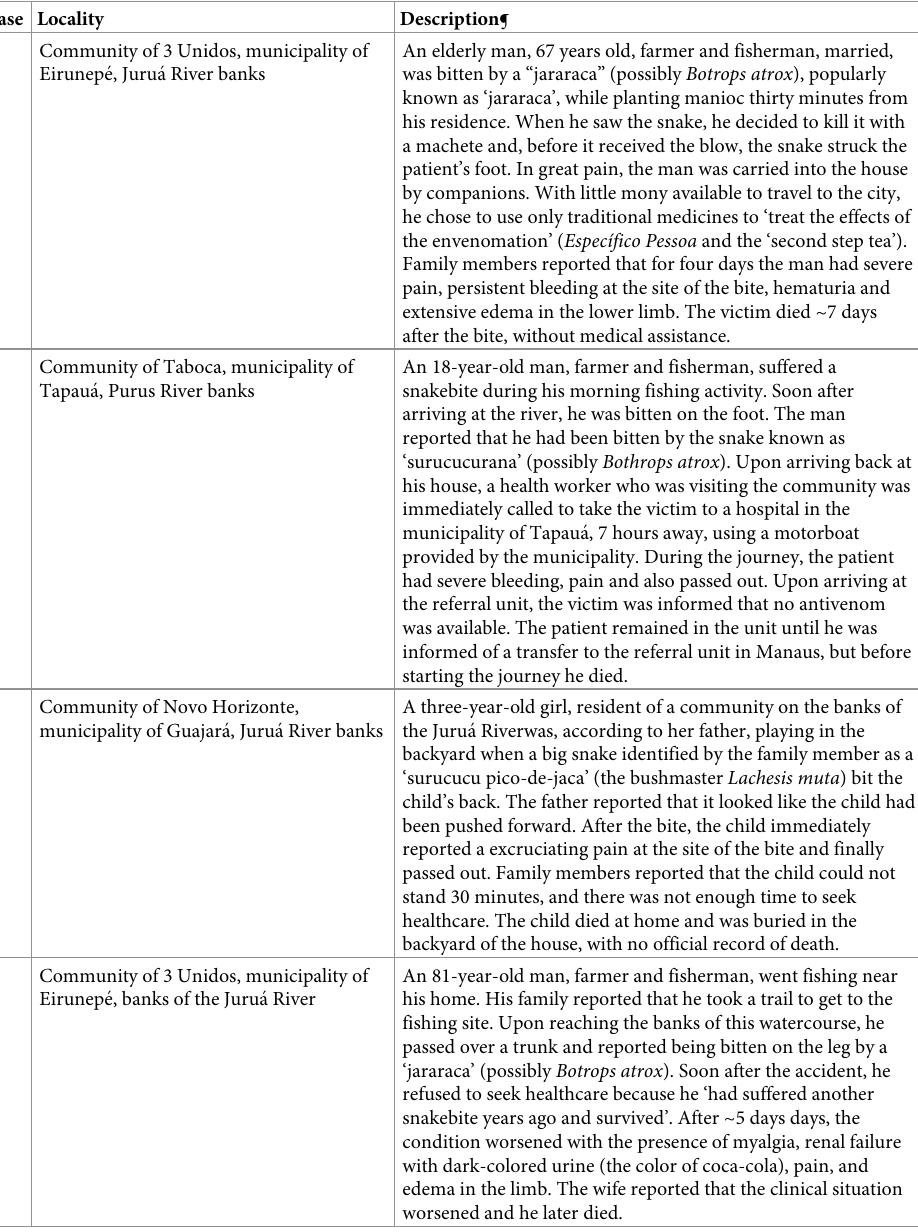
Table 4. Characteristics of the four deaths from snakebites as described by family